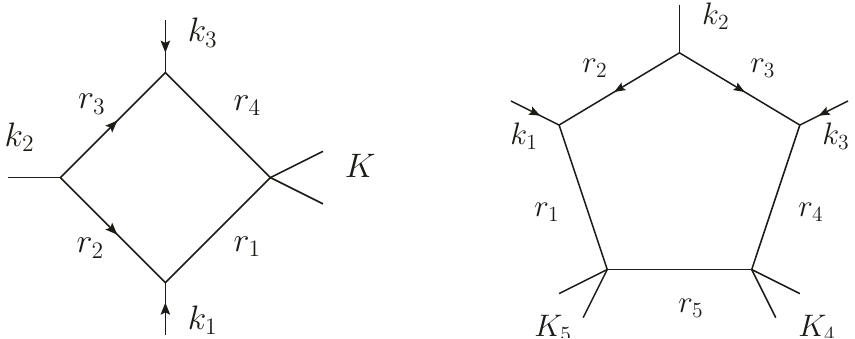
1 r 2 ~ r 3 3 de(cid:12)ned in eq. (D.4). Legs k 1 ; k 2 ; k 3 are h j j i